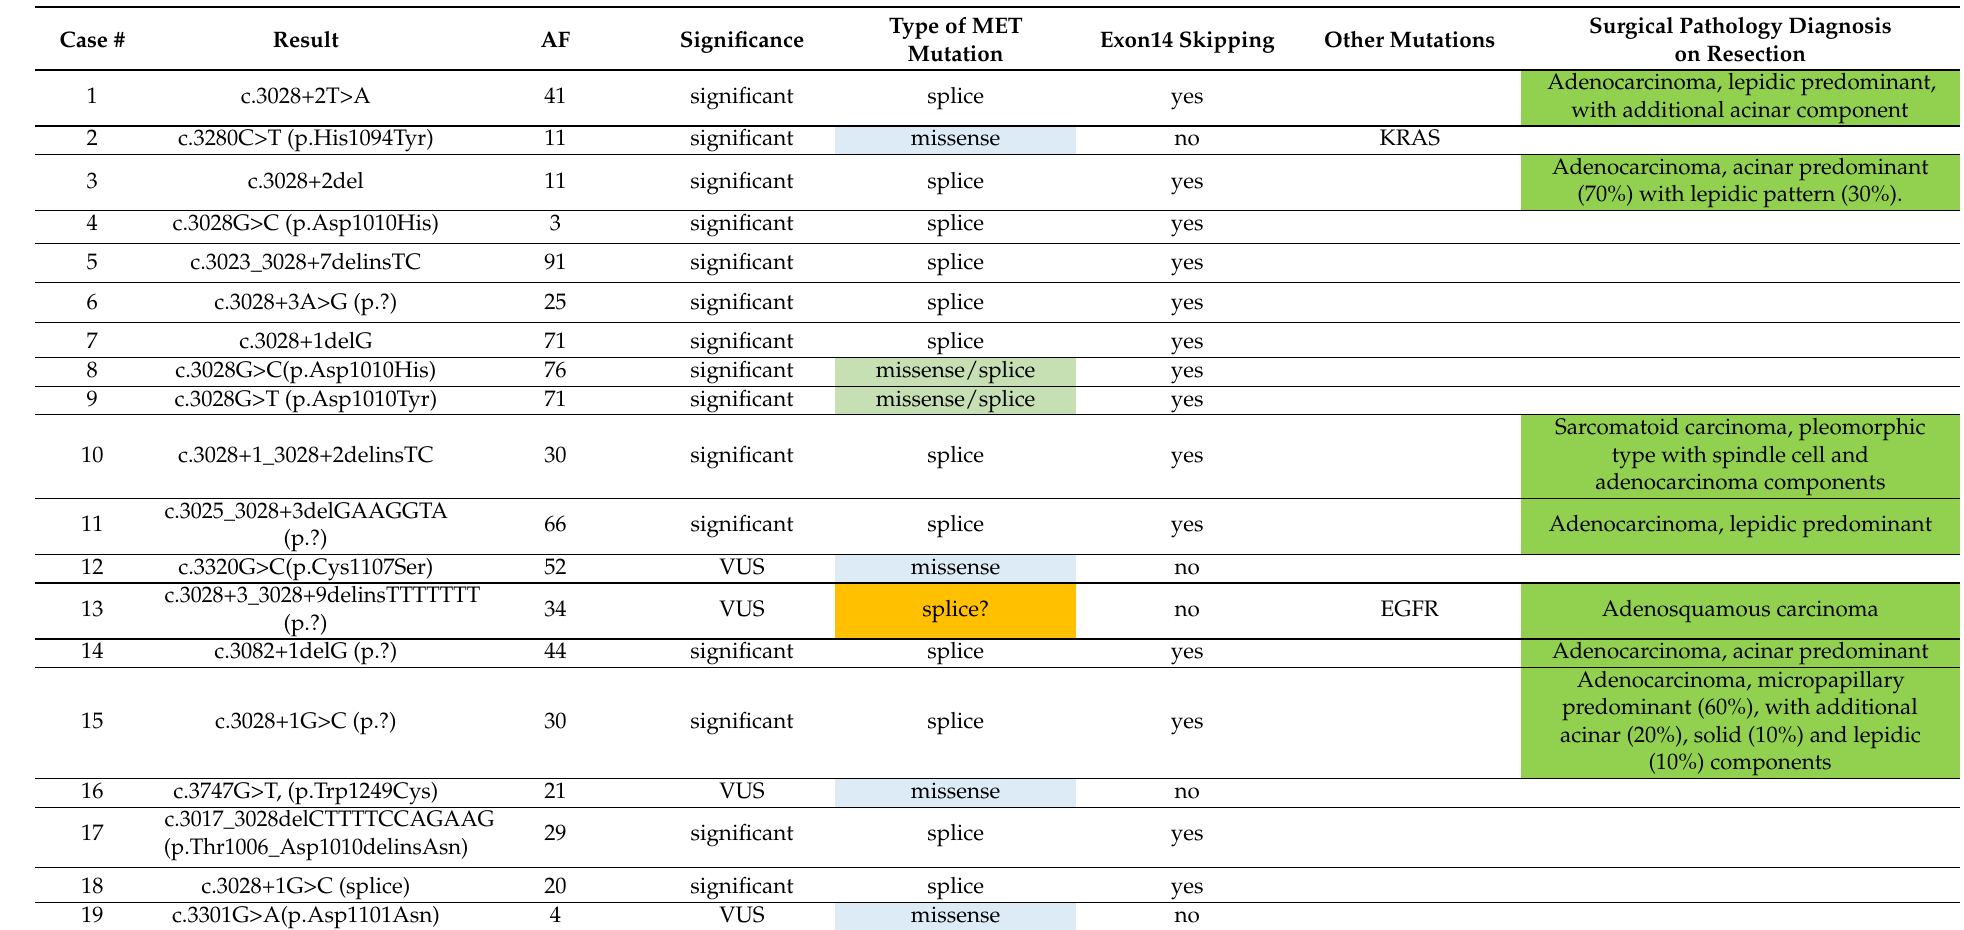
Table 2. Additional details on MET variants and clinicopathologic